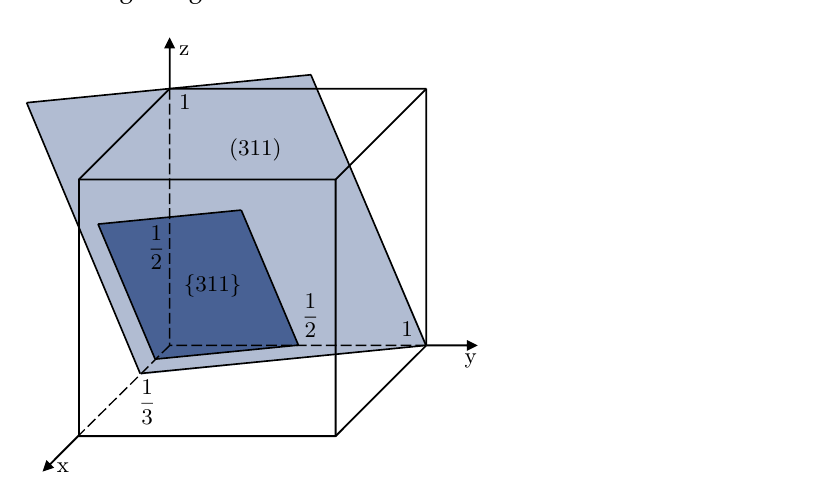
Figure 4. Orientation of the crystallographic planes {311} considered for residual stress evaluation according to